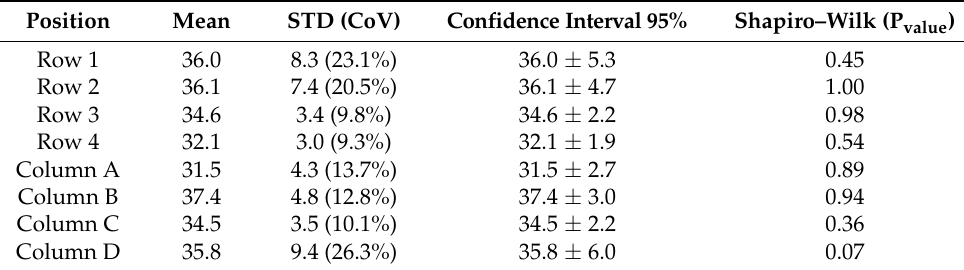
Table 5. Statistical description of the fibre quantity depending on the position.